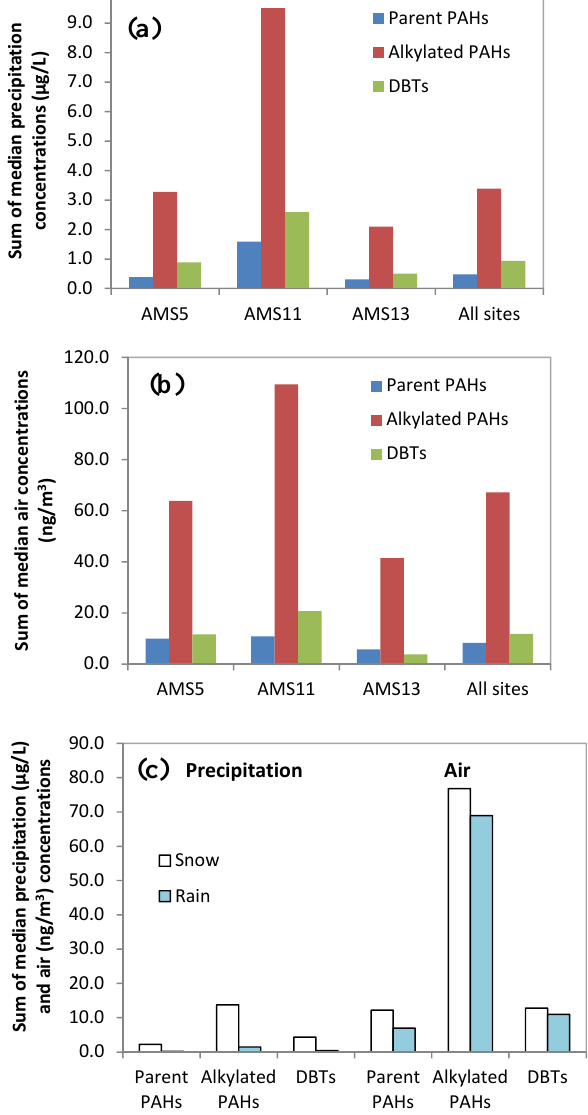
Figure 3. Sum of the median concentrations for parent PAHs, alky- lated PAHs, and dibenzothiophenes (DBTs) in (a) precipitation and (b) air. Comparisons of the precipitation and air concentrations for snow and rain samples are shown in (c) .